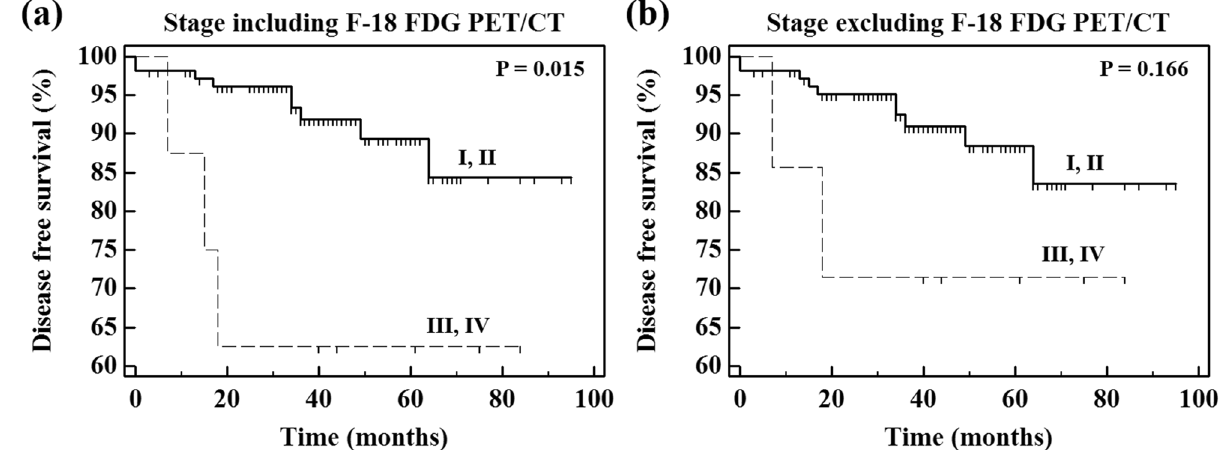
Figure 3. Comparison of Kaplan–Meier curves with respect to stage including F-18 FDG PET/CT ( a ) and stage excluding F-18 FDG PET/CT ( b ). This figure was made using MedCalc statistical software version 12.7.5.0 for Windows (Ostend, Belgium; https:// www. medca lc. org). F-18 FDG, fluorine-18-fluorodeoxyglucose; PET, positron emission tomography; CT, computed tomography.